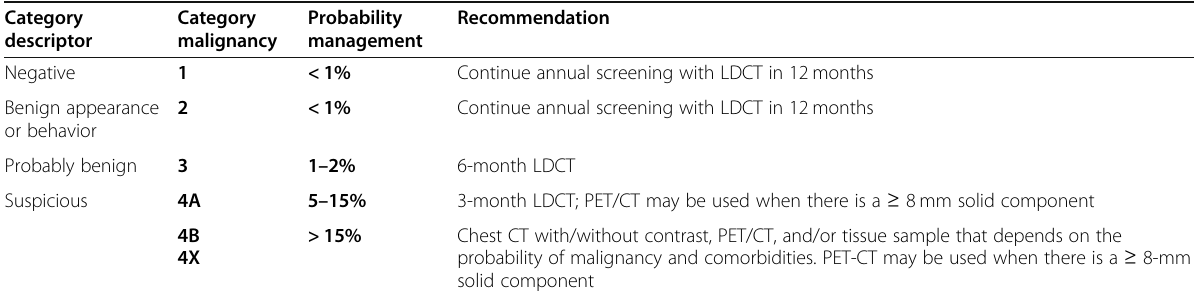
Table 1 Summary of Lung-RADS category